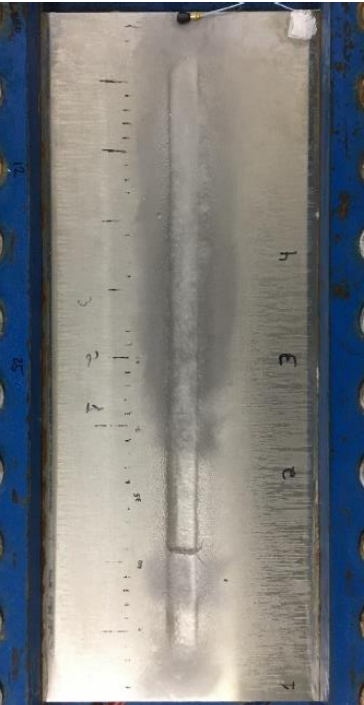
Figure 19. Cracking of the ice layer in steady-state mode at 1338 Hz and 320 Vpp.